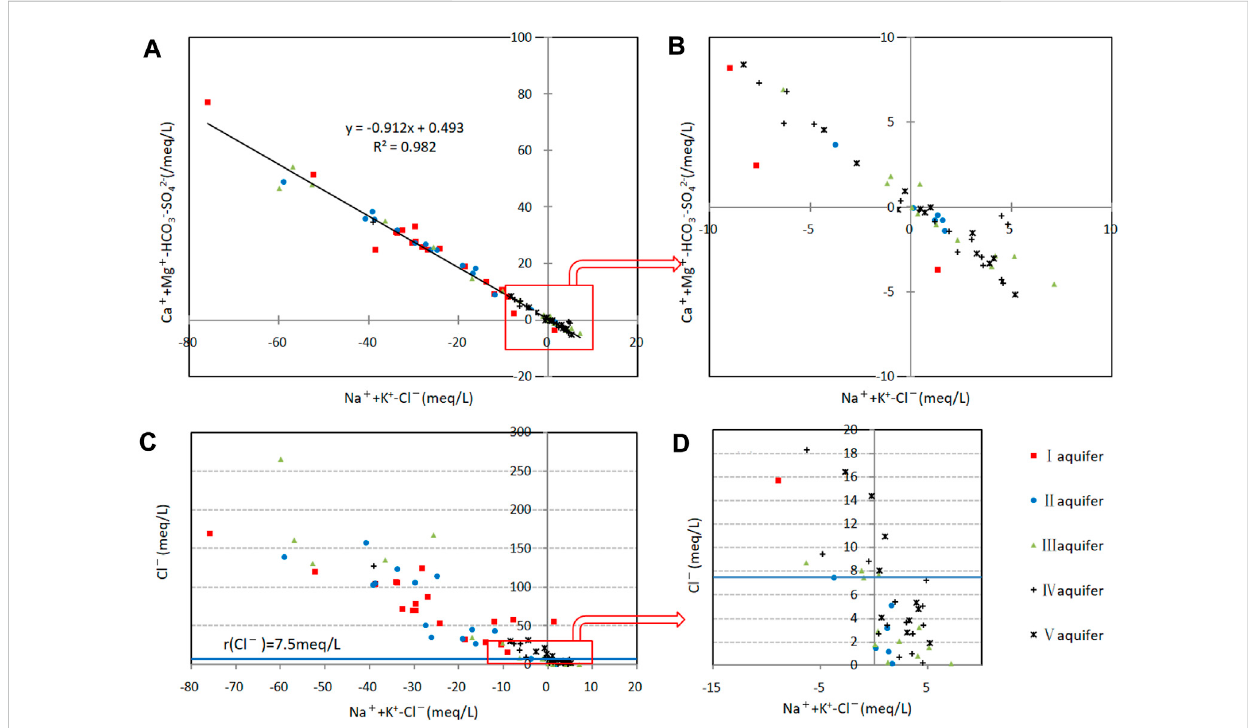
FIGURE 8 Cation-exchange analysis diagram of con fi ned groundwater. (A) Relationship between (Mg 2+ +Ca 2+ – HCO 3 − – SO 4 2 − ) and (Na + +K + – Cl − ) for all samples. (B) Relationshipbetween(Mg 2+ +Ca 2+ –